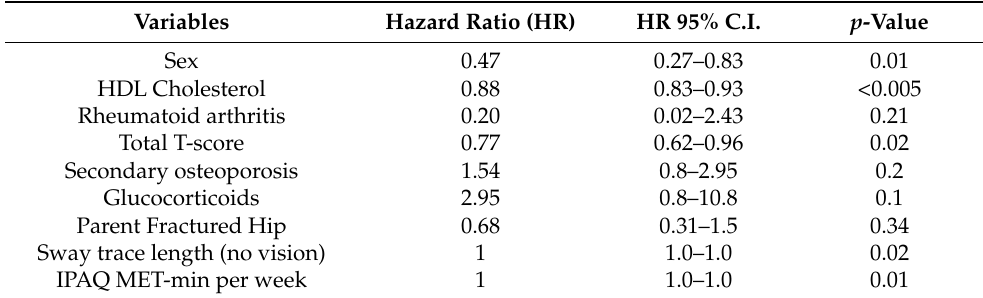
Table 1. Cox Model.